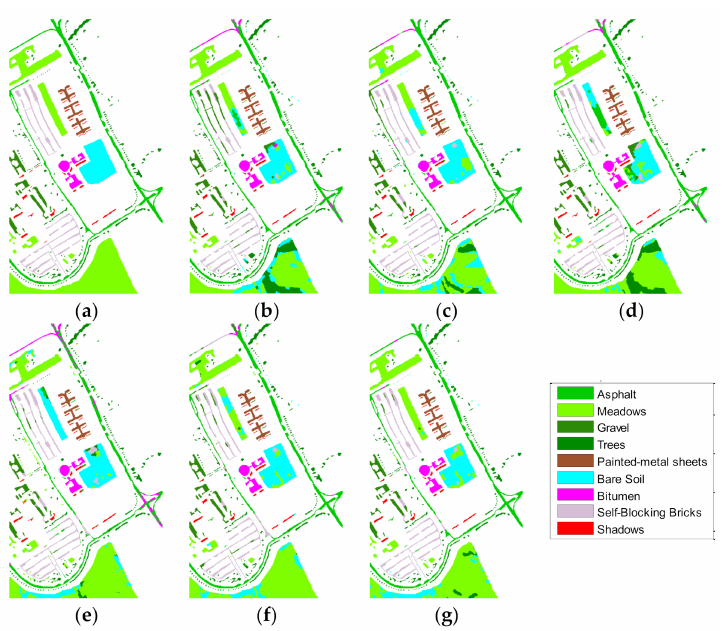
Figure 13. Classification results of different algorithms for Indian Pines data: ( a ) label ( b ) JSPR ( c ) RVCANET ( d ) HC-RMG ( e ) SKCR ( f ) HS_AGU and ( g )